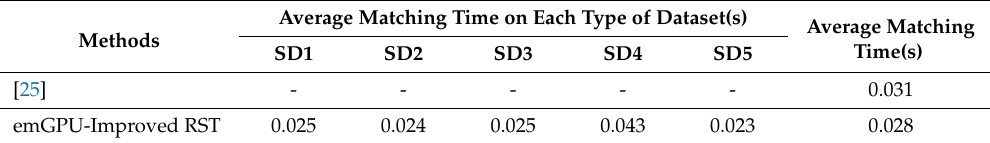
Table 5. The performance of the emGPU-Improved RST algorithm on the SD cards dataset.